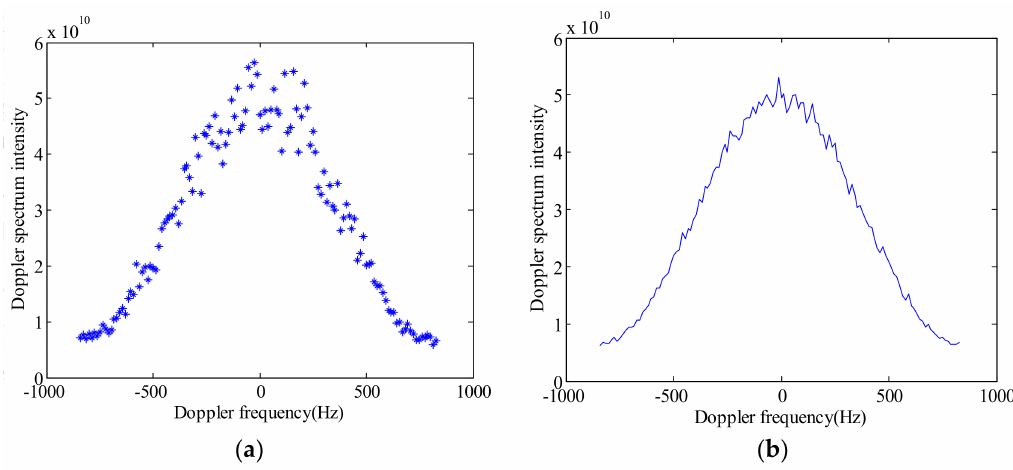
Figure 2. Simulated Doppler power spectrum. ( a ) Before multi-looking; ( b ) after